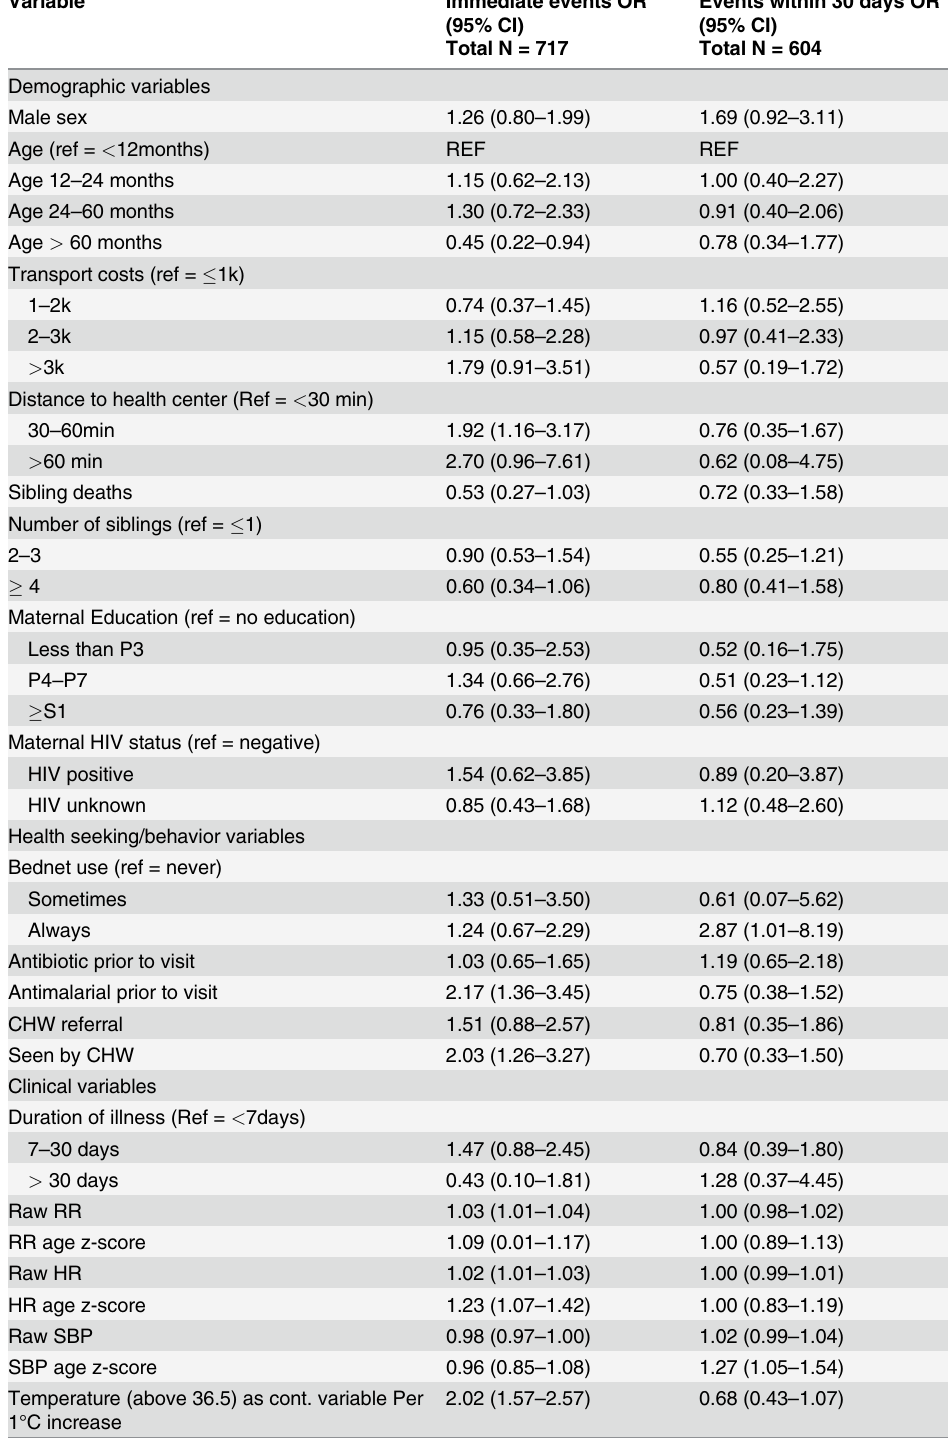
Table 4. Univariate association between baseline variables and immediate and early